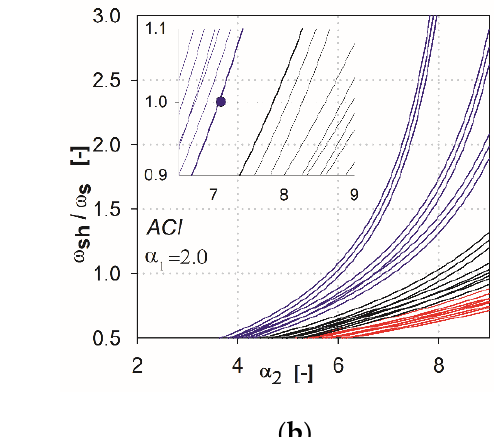
Table 2. Minimum values of the parameter 𝛼 2 , which satisfies the condition (2)—EC2.